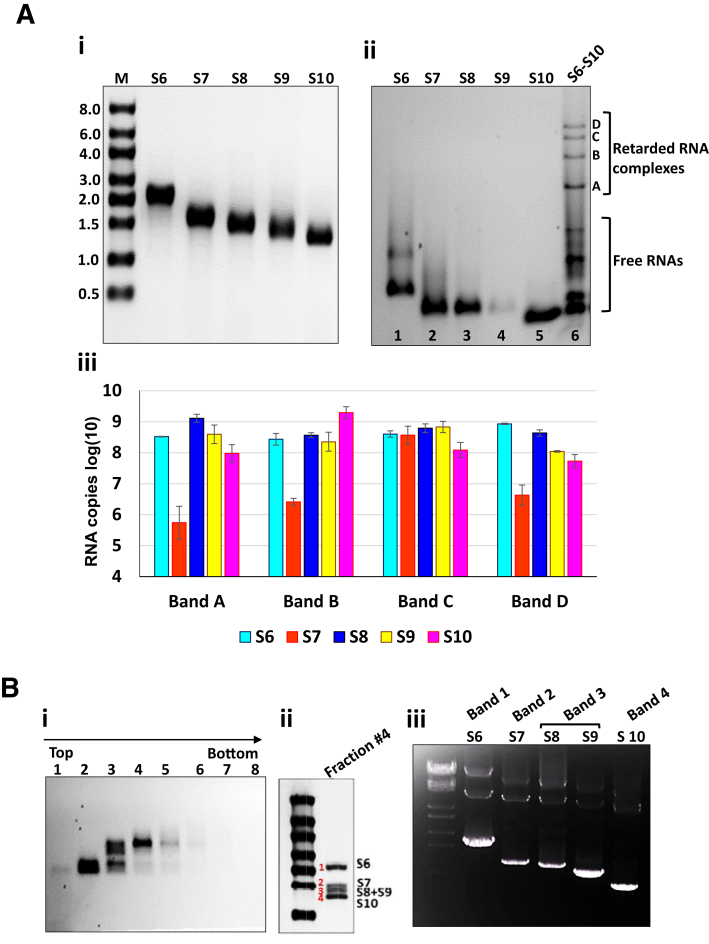
RNA–RNA interactions and complex formation between BTV segments. (A) EMSA and qRT-PCR analysis: (i) Single T7 transcription of BTV S6-S10 from cDNA. (ii) Native agarose gel shows the individual segments (lanes 1–5) or co-transcription of S6-S10 (lane 6). Retarded RNA complexes (bands A-D) and free RNAs are indicated. (iii) The quantities of S6–S10 in each retarded band were measured by qRT-PCR. The log (10) quantities are shown in bars, indicating standard deviations from multiple experiments. (B) Analysis by Sucrose gradient: i Co-transcribed complexes were subjected to a sucrose gradient ultracentrifugation, fractionated, RNA bands identified by EMSA. (ii) S6–S10 from fraction #4 are identified by denaturing gel. (iii) 1% gel electrophoresis of PCR products of fraction #4 bands extracted from denaturing gel.